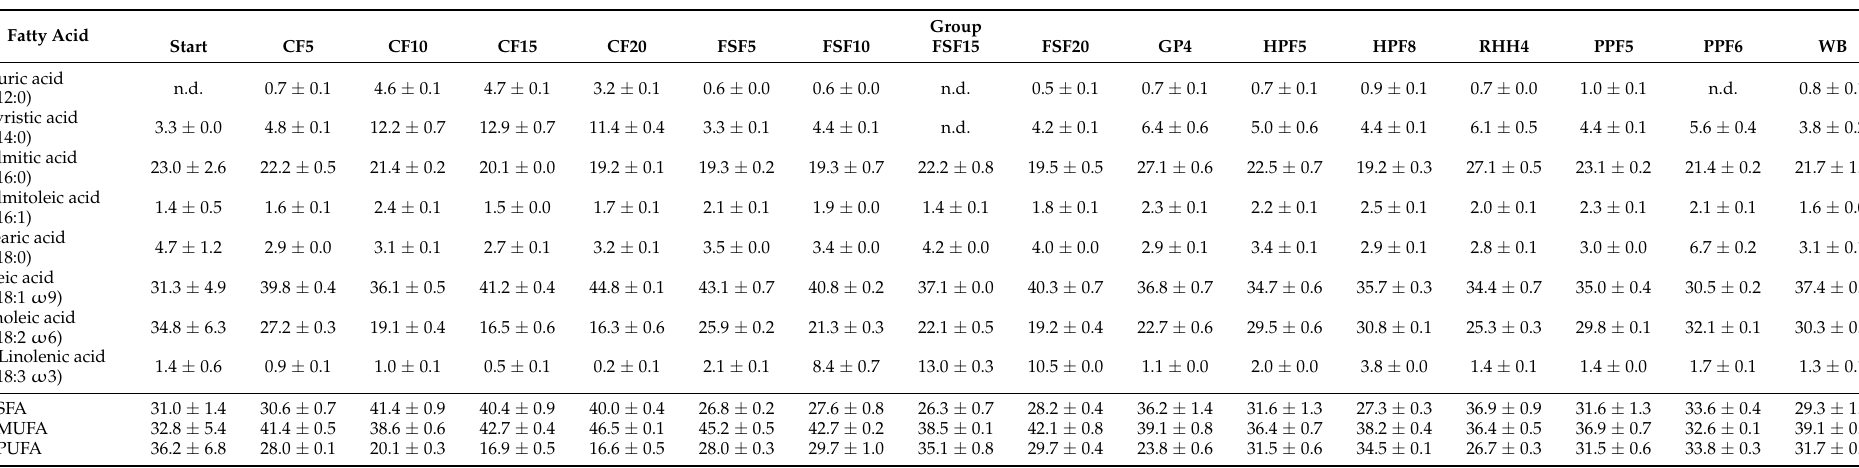
Table 3. Fatty acid composition of Tenebrio molitor larvae on a dry matter (DM) basis (relative% of total fatty acids). Data are presented as the mean ± standard deviation, n =